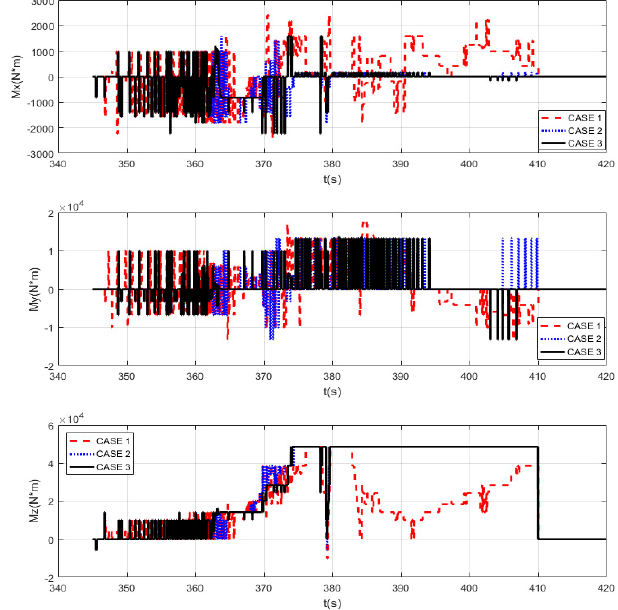
Figure 9. Reaction control system (RCS) moment comparison.